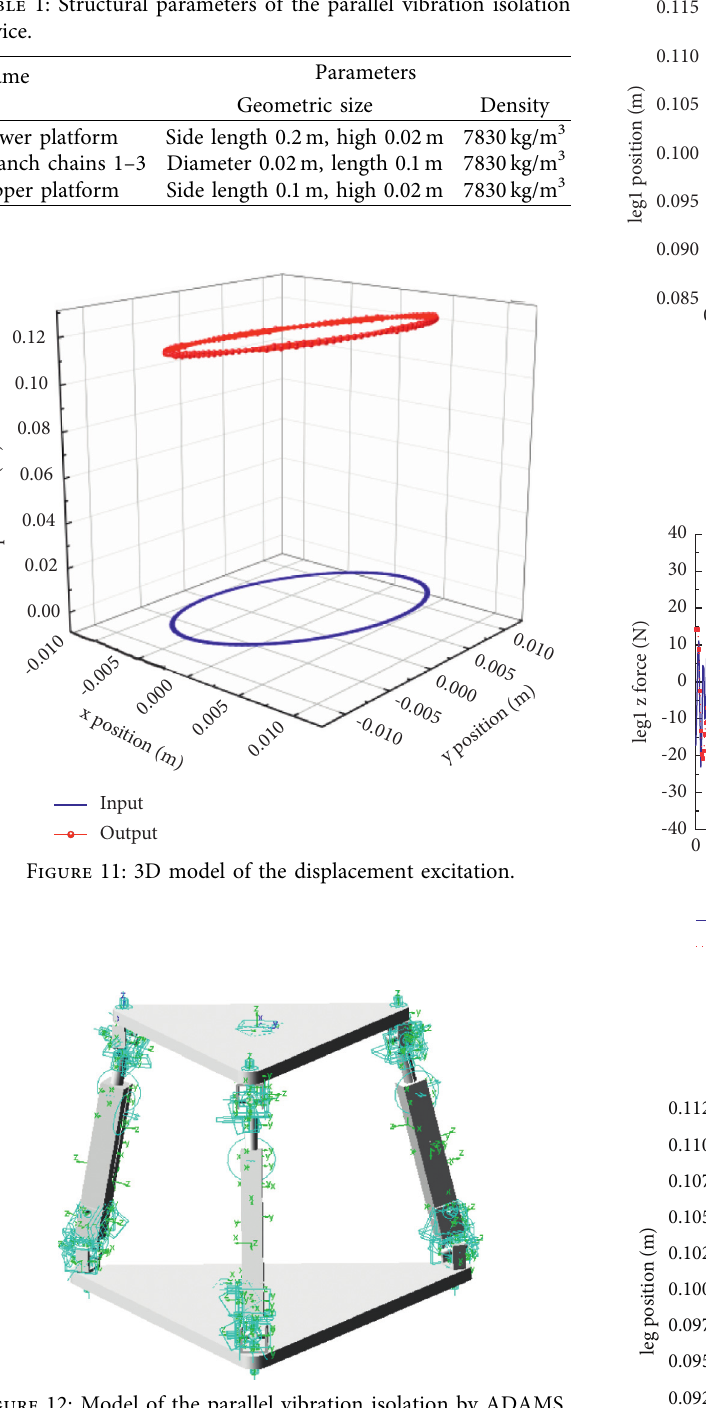
Figure 12: Model of the parallel vibration isolation by ADAMS.